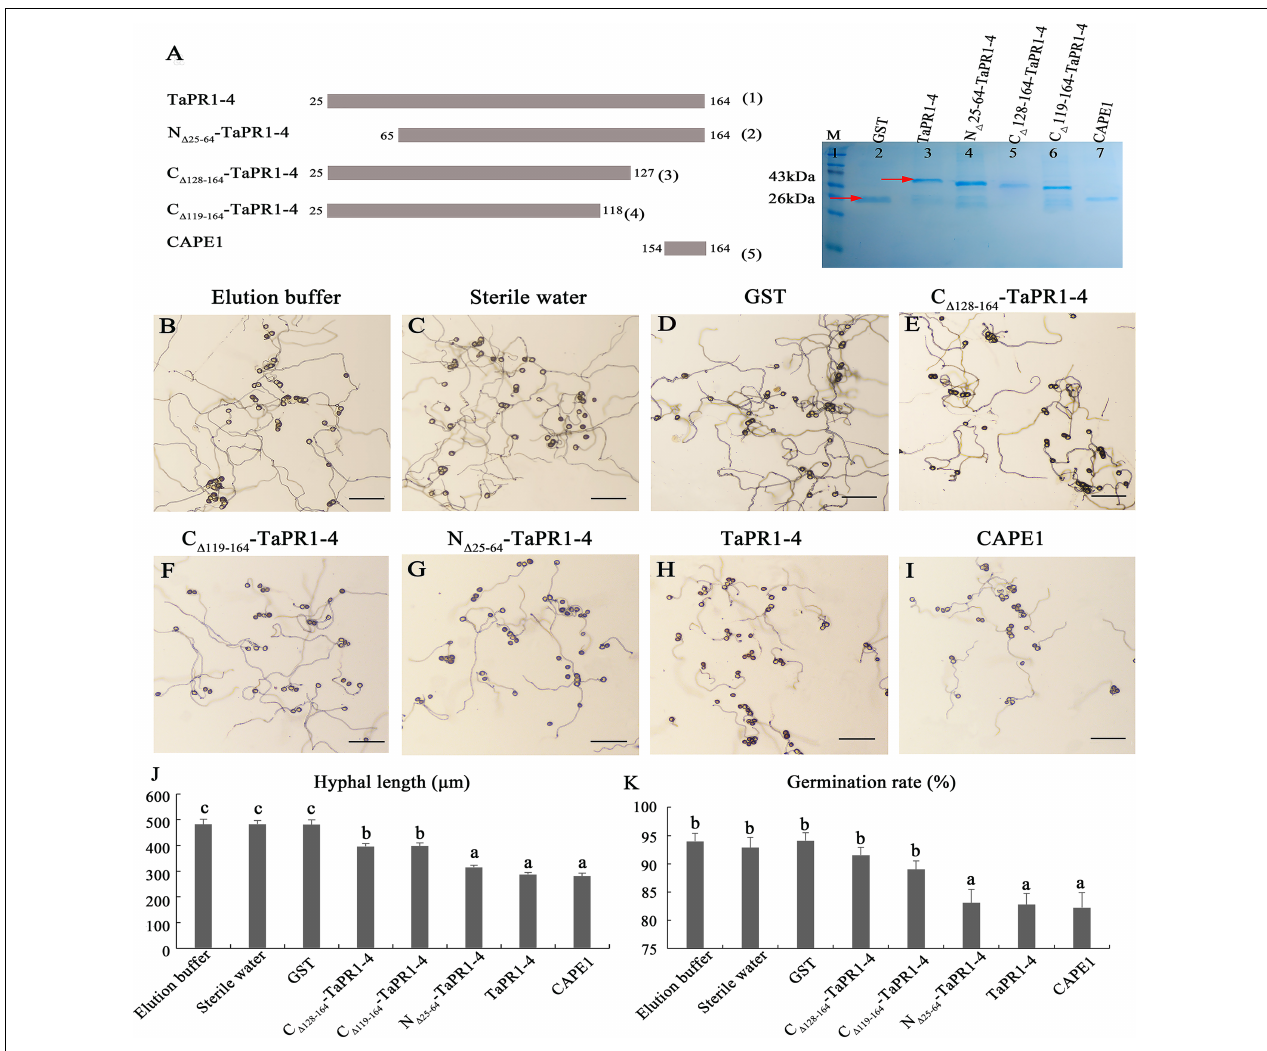
FIGURE 3 | The antifungal activity of TaPR1-4 in vitro . (A) Schematic of constructing site-directed mutagenesis and SDS-PAGE electrophoresis of purified proteins. Truncated TaPR1-4 constructs were generated including N-terminal deletion of residues 25–64 (N (cid:49) 25 − 64 -TaPR1-4), C-terminal deletion of residues 119–164 (C (cid:49) 119 − 164 -TaPR1-4), and deletion of residues 128–164 (C (cid:49) 128 − 164 -TaPR1-4). Lane 1 to lane 7 show that Marker, GST, TaPR1-4, N (cid:49) 25 − 64 -TaPR1-4, C (cid:49) 128 − 164 -TaPR1-4, C (cid:49) 119 − 164 -TaPR1-4, and CAPE1. The proteins were stained with Coomassie Brilliant Blue. Red arrows mark protein size. (B–I) The antifungal activity of TaPR1-4 on the 2% agar medium under 25 ◦ C dark for 12 h treated with elution buffer, sterile water, GST, C (cid:49) 128 − 164 -TaPR1-4, C (cid:49) 119 − 164 -TaPR1-4, N (cid:49) 25 − 64 -TaPR1-4, TaPR1-4, and CAPE1, respectively. Photographs were taken at 10 × magnification. Scale bar, 100 µ m. (J,K) The hyphal length and urediniospores germination rate were counted using Excel. Values are means ± SEM of three independent biological replicates. Significant differences were assessed using one-way analysis of variance (ANOVA) and Duncan’s multiple range test (DMRT) with p <